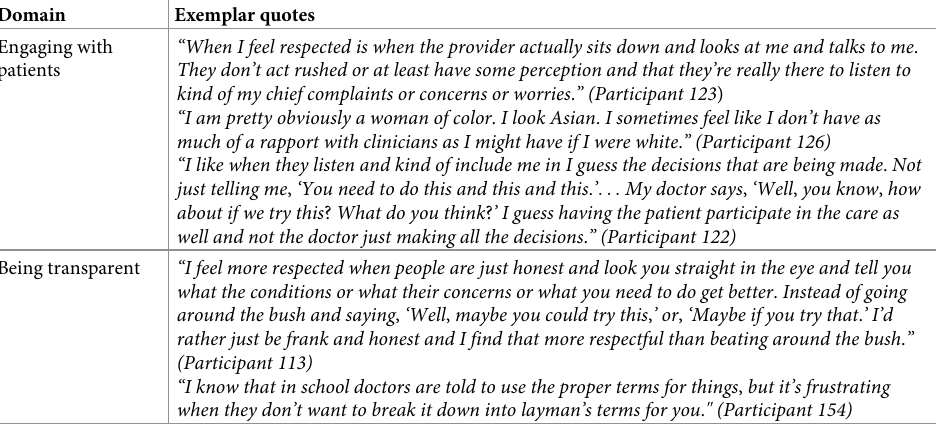
Table 3. Exemplar quotes–individual efforts that demonstrate respect in